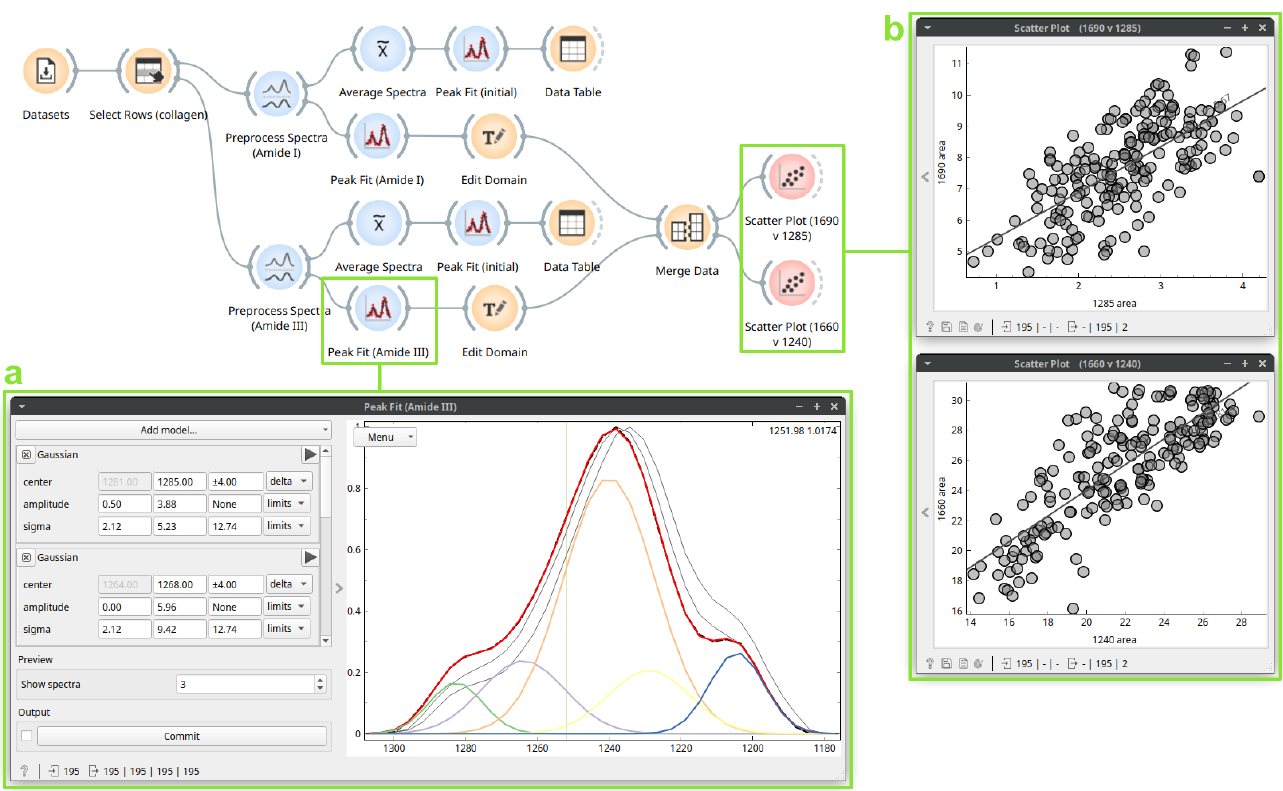
Figure 5. A workflow for protein secondary structure peak fitting. The Preprocess Spectra cuts the data to the Amide I or Amide III region, applies rubber band baseline and min-max normalization. The Average Spectra computes the average spectrum. The first Peak Fit (initial fits the average spectrum with constraints and default initial values. The second Peak Fit (box a ) computes the fit for each spectrum, using initial amplitude and sigma values from the average fit. The Edit Domain labels the peak area features by center wavenumber. The Merge Data combines the Amide I and Amide III peak fit datasets. Finally, the Scatter Plot widgets (box b ) show the relationship between selected peak areas for the entire